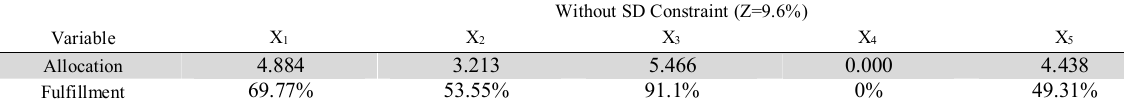
Optimization results without SD constraint